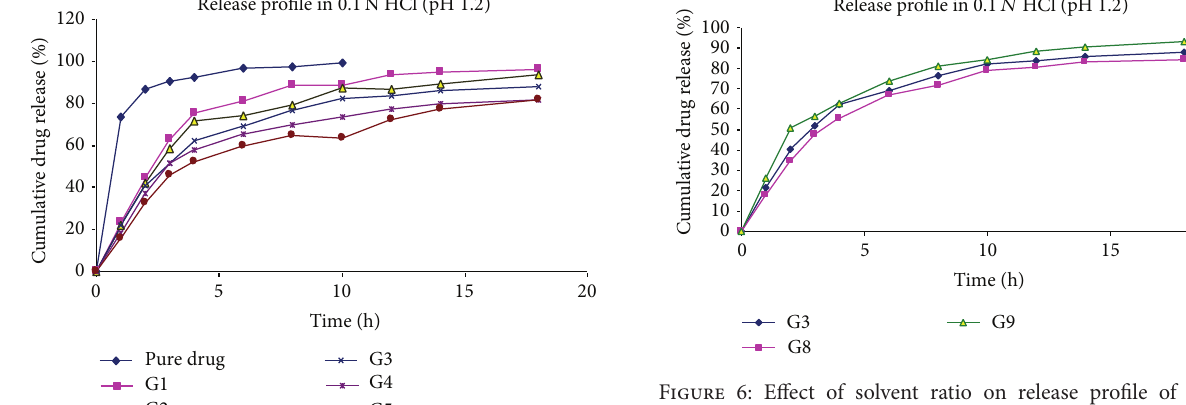
Figure 6: Effect of solvent ratio on release profile of 5-Fu in 0.1